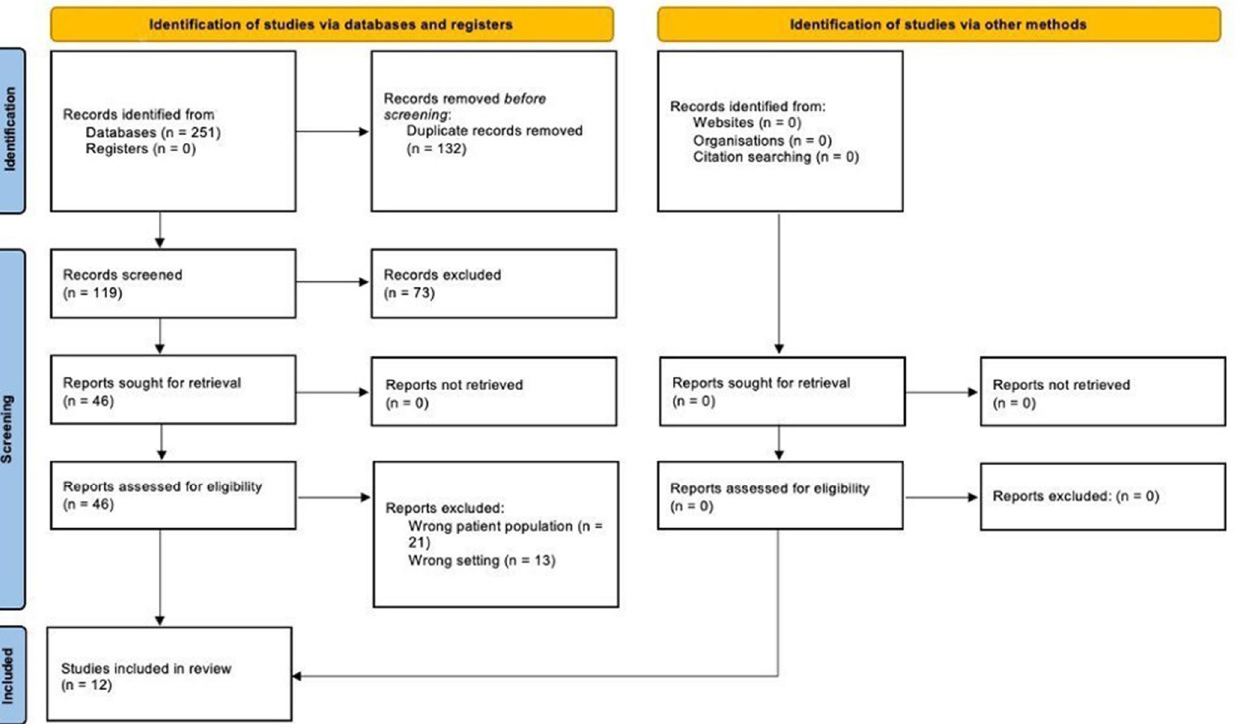
Table 1. Critical review of the selected manuscript [42].